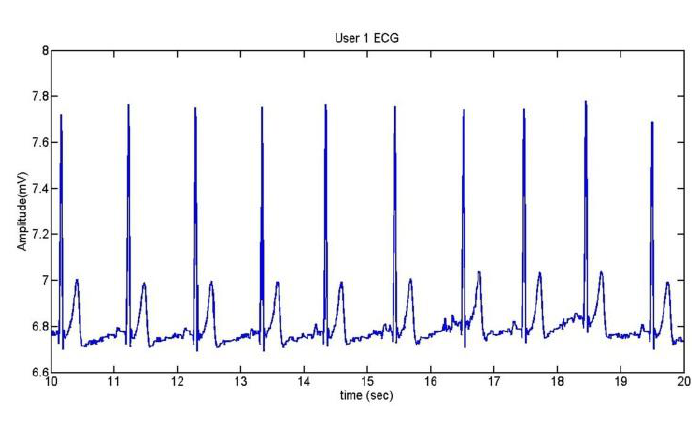
Figure 18. User 1 ECG.